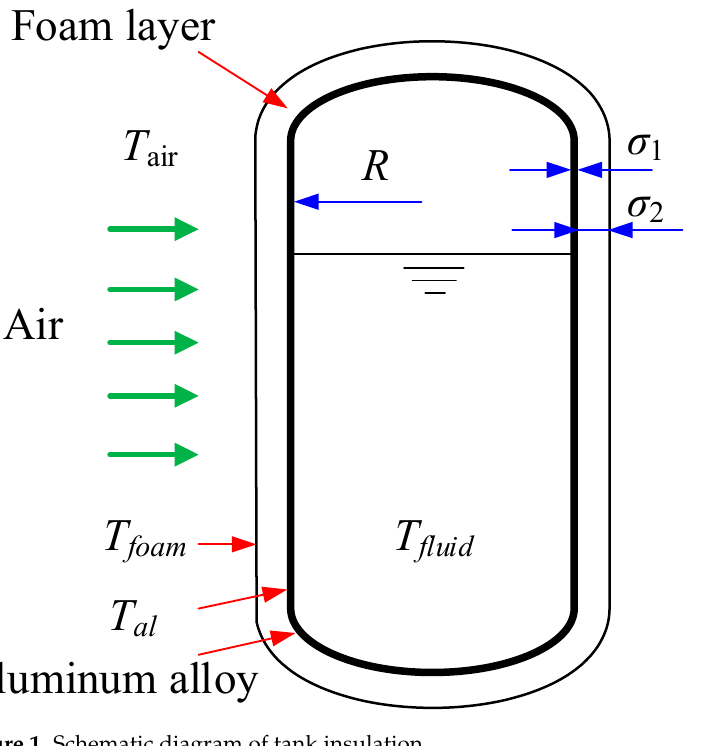
Figure 1. Schematic diagram of tank insulation.